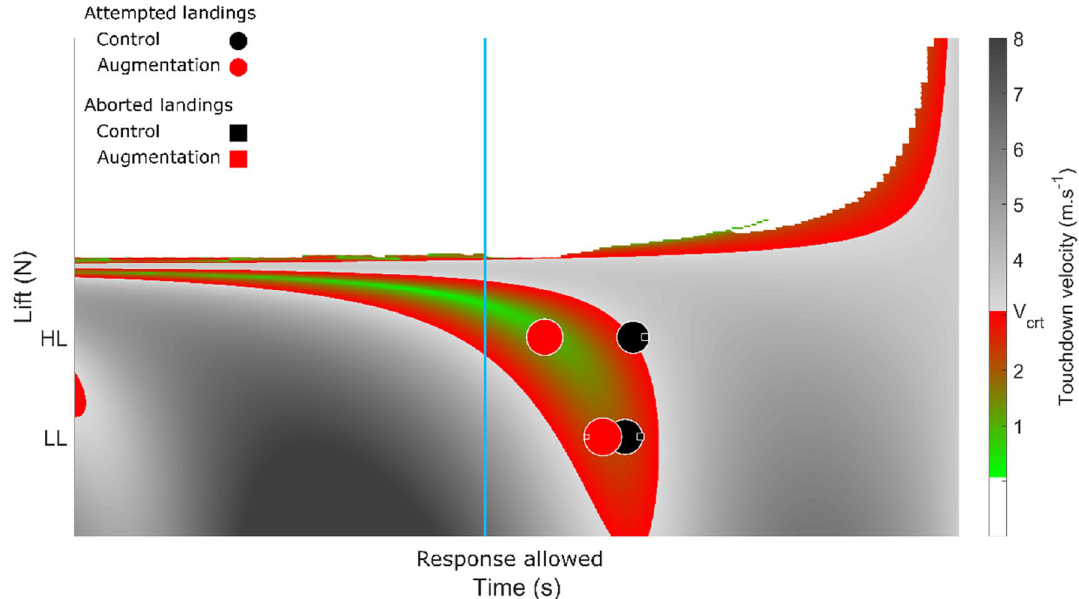
Figure 8. Inter-individual average frequency of attempted and aborted deck-landing (circles and squares symbols, respectively) under Control and Augmentation conditions (black and red, respectively) plotted in the condition [9 m; 0 rad] in which safe deck-landing was possible ( π optimal = 0.70 and 0.32 with groups LL and HL, respectively) over the deck-landing-ability landscape. The size of the symbols reflects the frequency of decisions. attempt V crt , thus indicating the safety of the deck-landing The green to red colors encode the distance from V td to attempt. Light to dark gray show unsafe deck-landing situations where V td > V crt